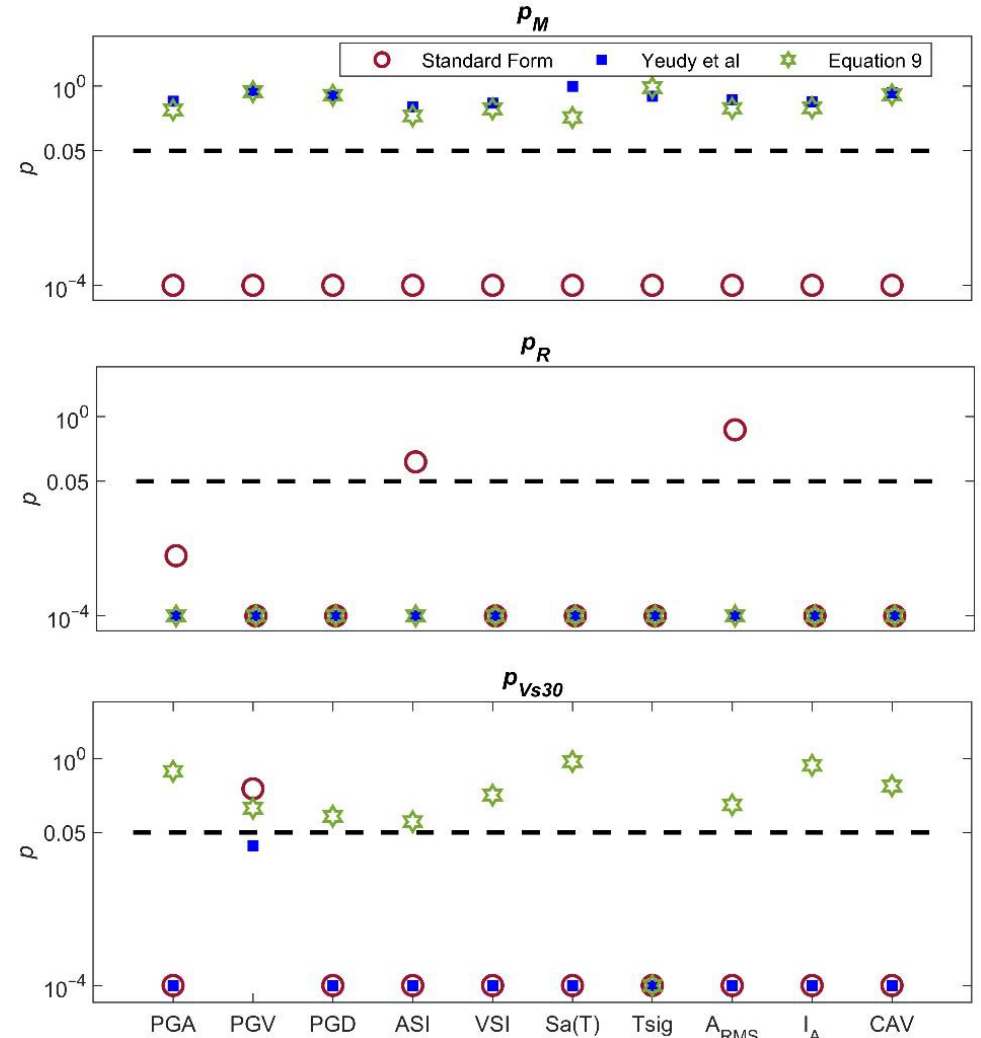
Figure 13. Sufficiency analysis in terms of p values of different functional forms and IMs. The dotted line marks the p = 0.05 threshold for classifying sufficient ( p > 0.05) and insufficient IMs ( p < 0.05). Very low p values ( p < 10 − 4 ) are plotted at p = 10 − 4 level. Equation (1) does not show sufficiency with any parameter for most of the analyzed IMs. Equation (24) shows sufficiency only with M w . Equation (26) shows sufficiency with respect to M w and Vs30 for most IMs. With respect to Vs30 , the IMs are sufficient for Equation (26) and insufficient for other functional forms. With respect to epicentral distance ( R epi ), none of the functional forms show sufficiency. This observation contradicts Yeudy’s findings that all the IMs are sufficient ( p > 0.05) when using their proposed IM-EDP relation (Equation (24)). This inconsistency may arise from the different near-field ground motion dataset used in their study. While Yeudy’s dataset considers many small magnitude events ( M w < 5) at distances less than 50 km, large events ( M w > 5) dominate our dataset at least up to 100 km. The seismic energy radiated from these larger-magnitude earthquakes has different attenuation behavior with distance, contributing to variations in the predicted EDP. Small magnitude events produce ground motions that attenuate faster at shorter distances, while large events attenuate more gradually over larger distances. To verify, we divide our ground motion dataset into distance bins and calculate p R values (Figure 14). When grouped into distance bins, we observe sufficiency for most IMs in the 30–100 km